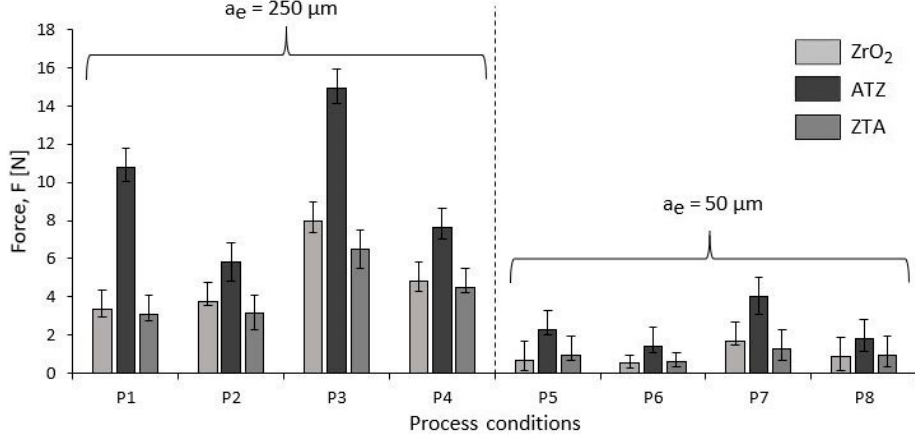
Figure 8. Mean forces Fy (N) for the grinding processes per material. (Table A2).